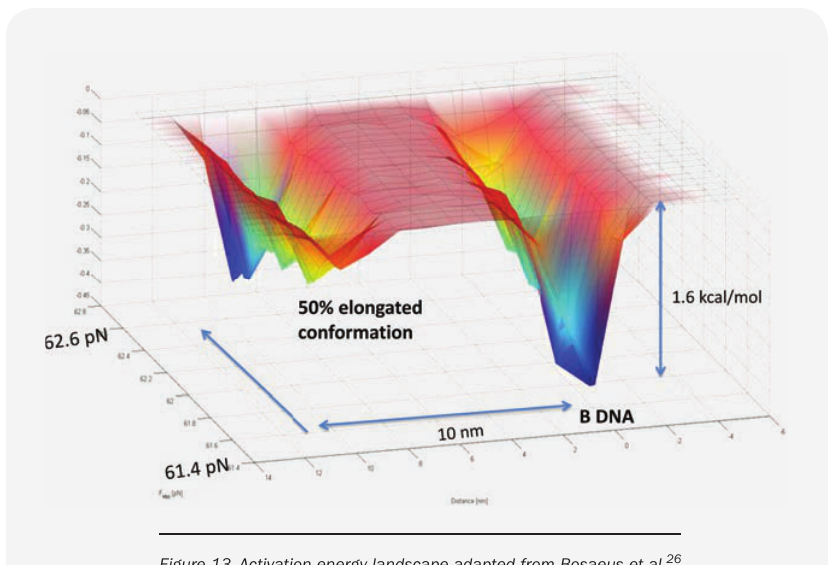
Figure 13. Activation energy landscape adapted from Bosaeus et al. 26